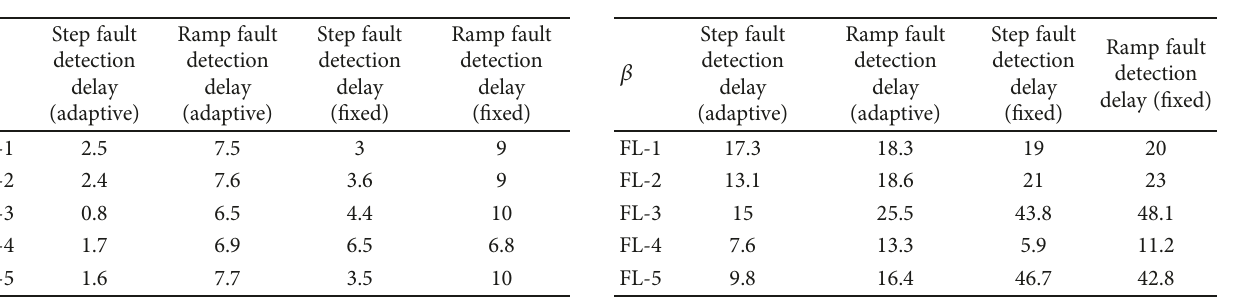
(c) Comparison between fi xed-threshold and adaptive-threshold detection delay for β : soft